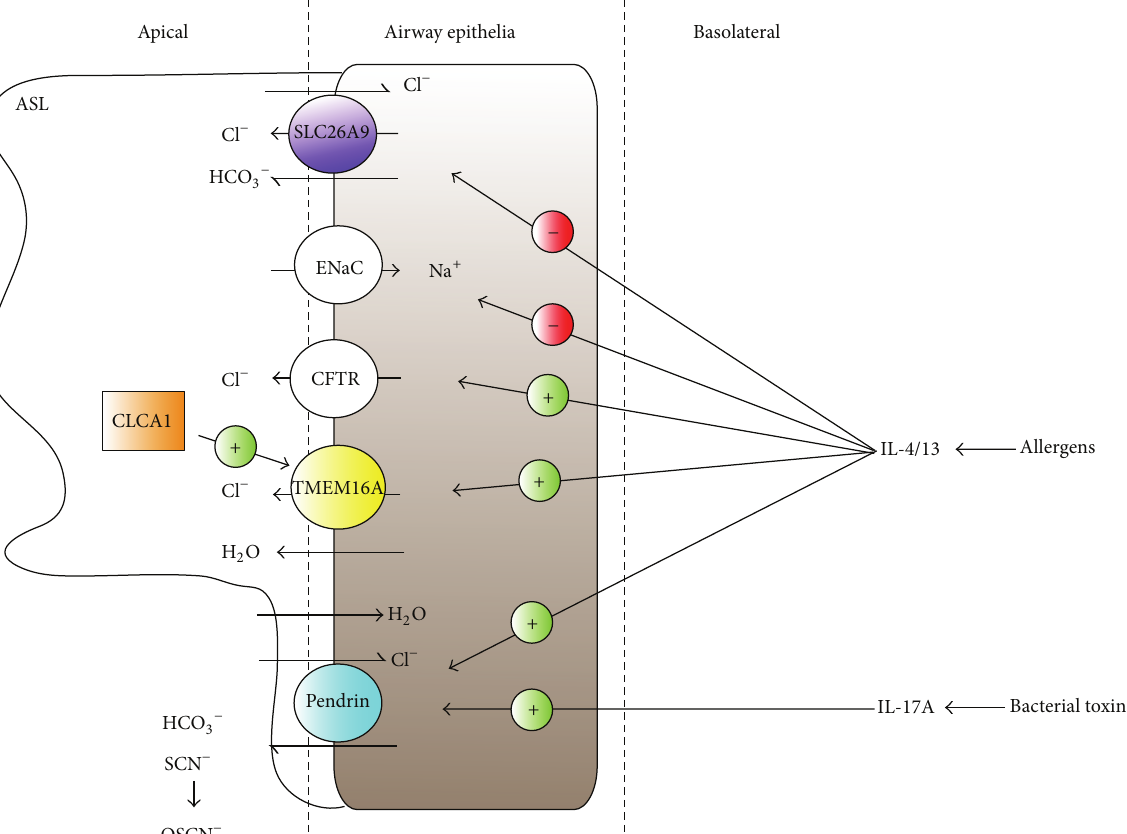
Figure 5: Roles of ion channels in the airway epithelium. In response to allergens and other asthma and COPD exacerbating factors, Th2- cytokines IL-4 and IL-13 induce a water secretory phenotype by stimulating Cl − secretion via CFTR and Ca 2+ -activated Cl − channels such as TMEM16A and by decreasing Na + and Cl − reabsorption via ENaC and SLC26A9, respectively, which leads to the thickening of the airway surface liquid (ASL). TMEM16A activity can be increased by secreted CLCA1 protein. In concert, signaling through IL-4/IL-13 increases the functional expression of pendrin, which results in reabsorption of water and thinning of the ASL. Pendrin can also increase the secretion of thiocyanate(SCN − ),asubstratefortheproductionoftheantimicrobialagenthypothiocyanite(OSCN − )bythelactoperoxidasesystem.Toxins from B. pertussis and other bacteria trigger an IL-17A-mediated inflammatory host response in the lung epithelium, which is characterized by a significant upregulation of pendrin